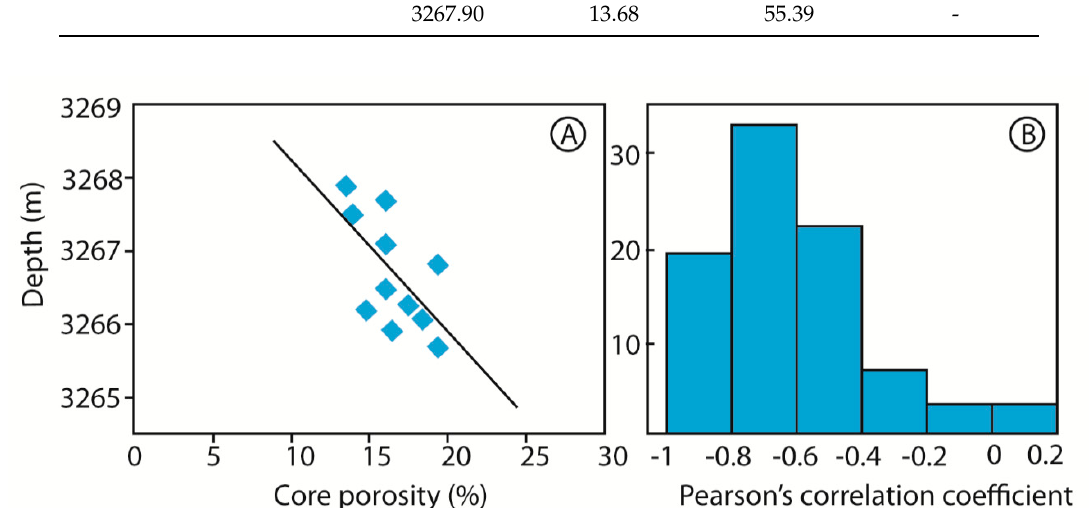
Figure 4. ( A ) Change of core porosity in relation to depth of Shahbazpur#2 sandstone samples; ( B ) histogram of bootstrapped Pearson’s correlation coefficient.